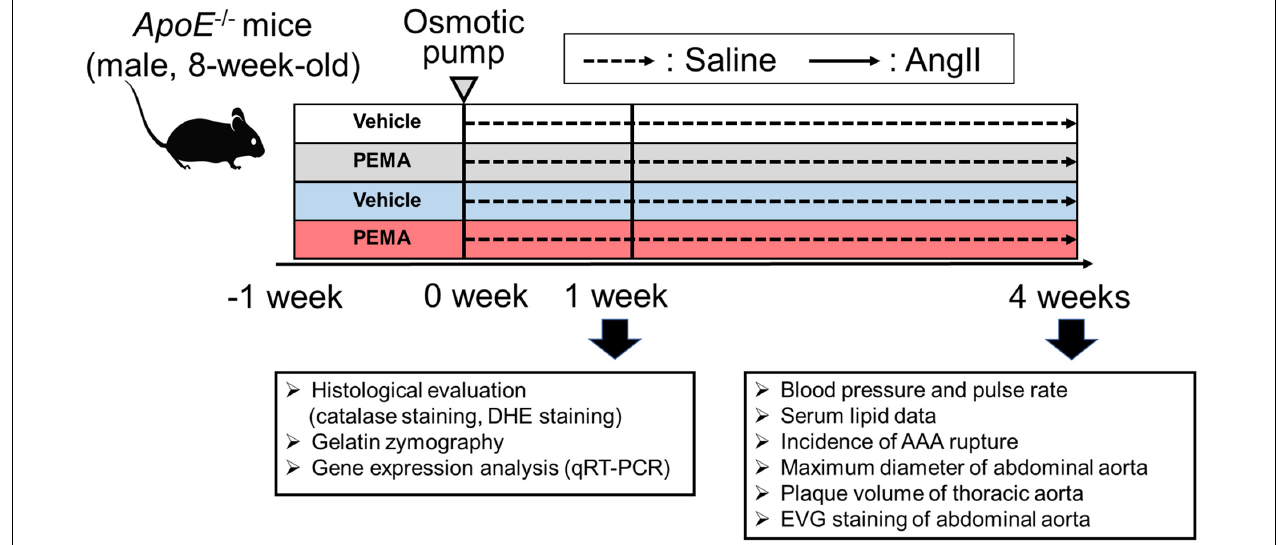
FIGURE 1 | Animal experiment protocol. To develop an experimental abdominal aortic aneurysm (AAA) model, 8-week-old ApoE-/- male mice were infused with angiotensin II (AngII) (1,000 ng/min/kg) or saline for 4 weeks. To assess the effect of pemafibrate, treatment with vehicle or pemafibrate (PEMA) (0.1 mg/kg/day) was initiated 1 week before administration of AngII or saline, resulting in four treatment groups: vehicle-treated saline-infused ( n = 10), pemafibrate-treated saline-infused ( n = 10), vehicle-treated AngII-infused ( n = 25), and pemafibrate-treated AngII-infused ( n = 25). Five mice in each group were euthanized to evaluate the early changes after AngII infusion. Blood pressure and heart rate were measured using the tail-cuff method before and 4 weeks after AngII infusion. All mice were euthanized at their respective endpoints under anesthesia. DHE, dihydroethidium; EVG, Elastica van Gieson; qRT-PCR, quantitative reverse transcription polymerase chain